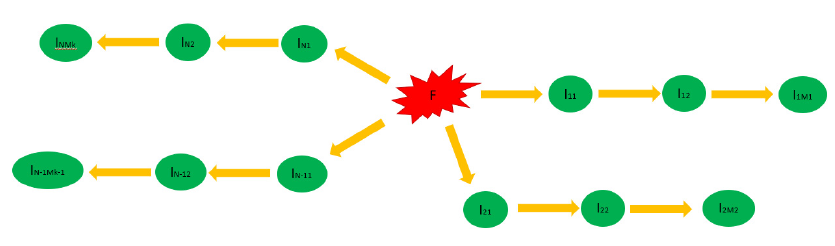
Figure 5. Mixed typology (F: Fire, Ii: Infrastructures, N: number of interdependent chains, Mk: number of interdependent infrastructures per each chain).